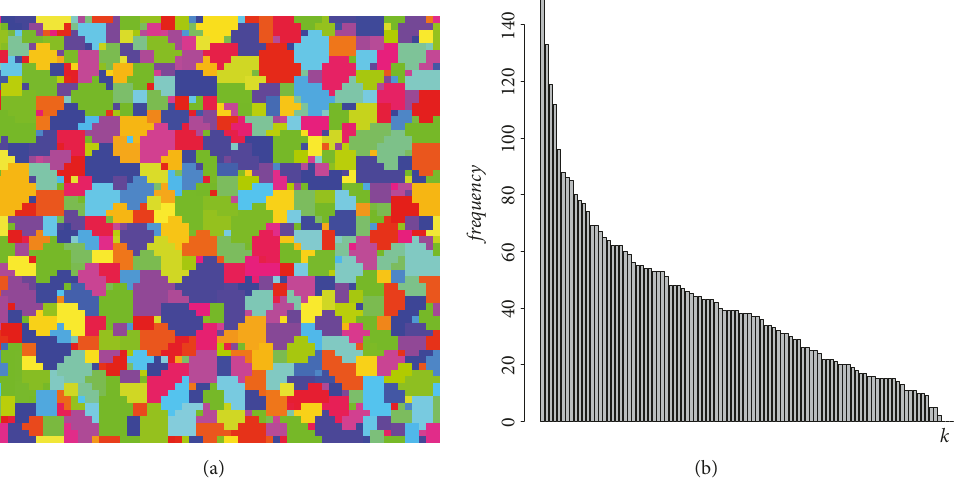
Figure 10: Example of a fixed point solution for 𝑠 = 10 , 𝑝 𝑎 = 0.75 , and 𝑝 𝑏 = 0.25 . (a) The spatial patterns of selected schools (the colormap labels the states {1,2,. .. 100} ). (b) The distribution of the number of students per